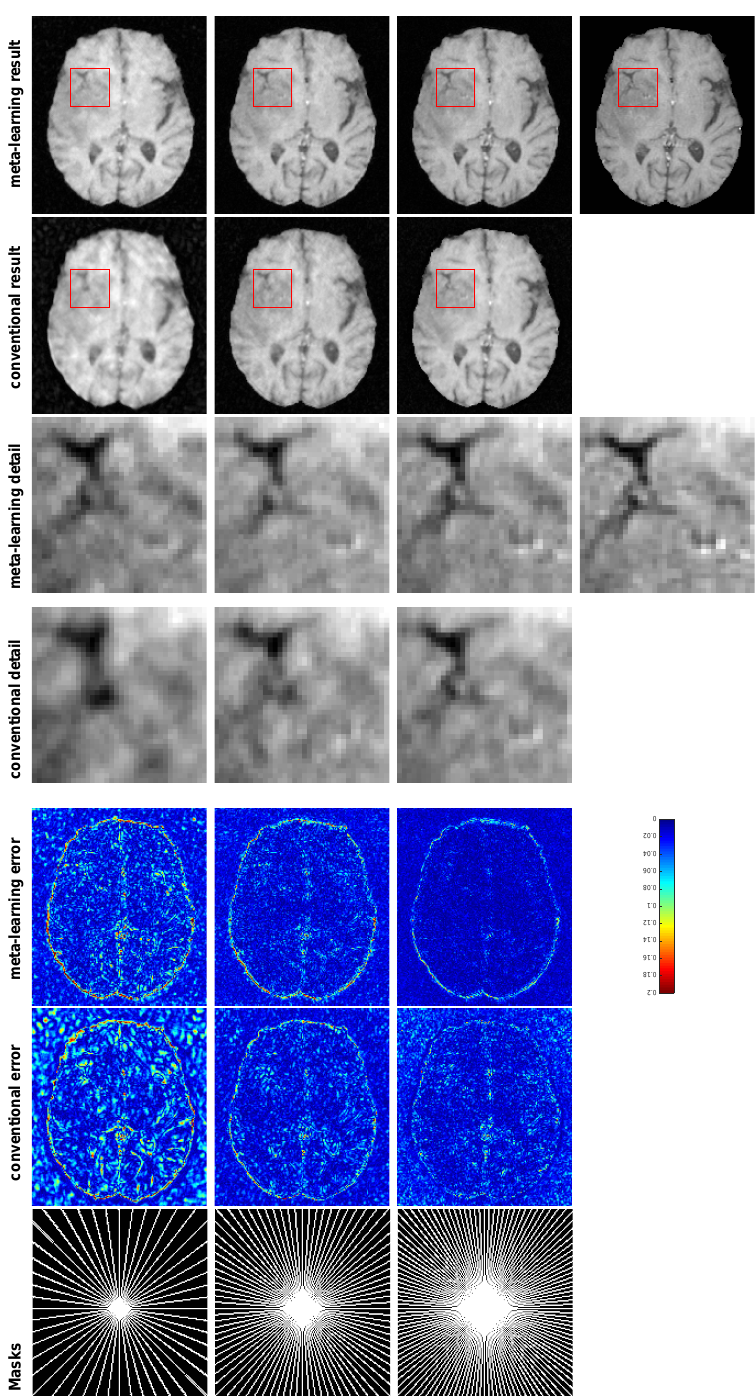
Figure 3. The pictures (from top to bottom) display the T1 brain image reconstruction results, zoomed-in details, point-wise errors with a color bar, and associated radial masks for meta-learning and conventional learning. Meta-learning was trained with CS ratios of 10%, 20%, 30%, and 40% and tested with three different unseen CS ratios of 15%, 25%, and 35% (from left to right). Conventional learning was trained and tested with the same CS ratios of 15%, 25%, and 35%. The top-right image is the ground truth fully-sampled